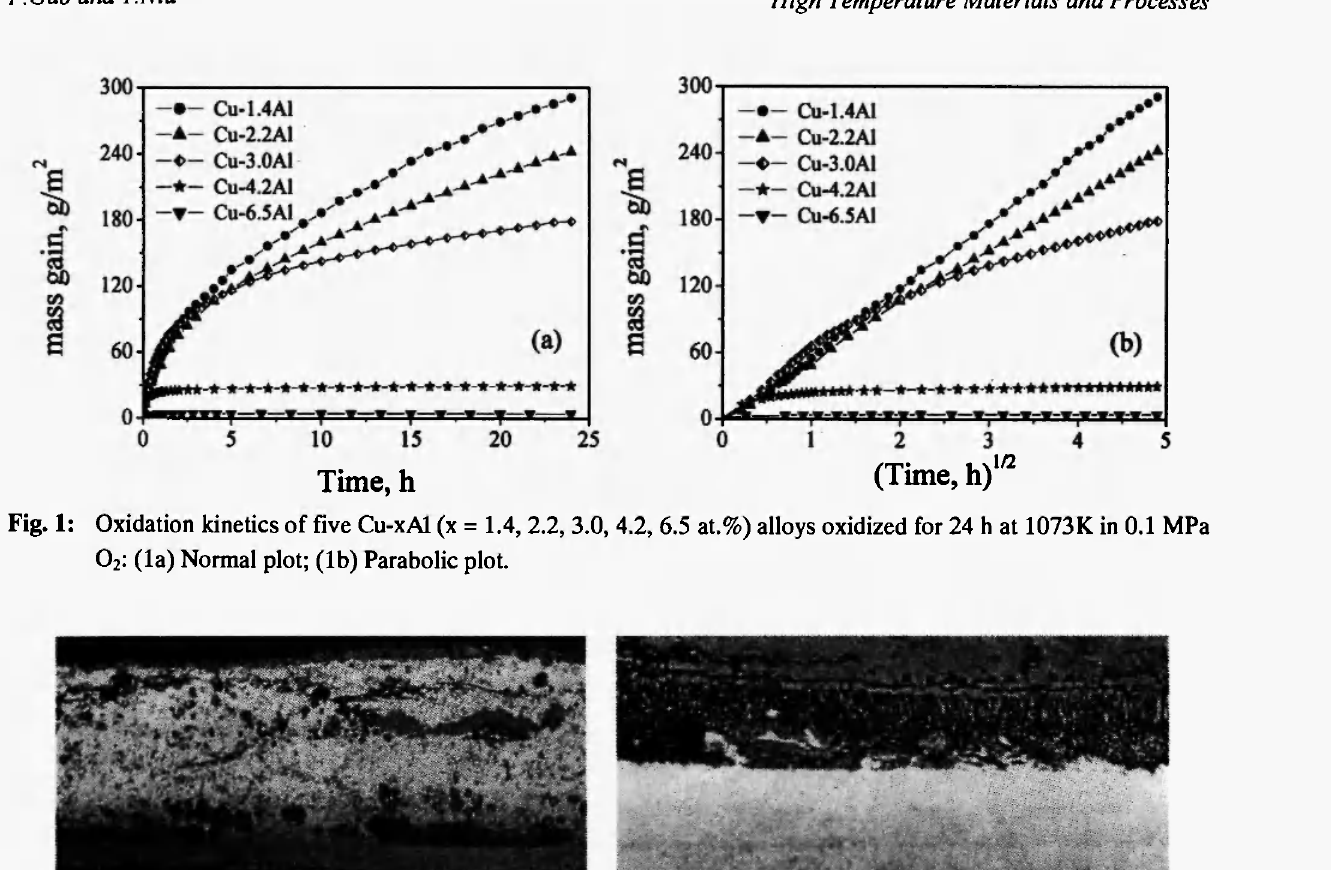
Fig. 2: Micrographs (SEM/BEI) of a cross section of Cu-1.4A1 oxidized for 24 h in 0.1 MPa 0 2 at 1073K: (2a) General view; (2b) Expanded view of the internal oxidation zone.